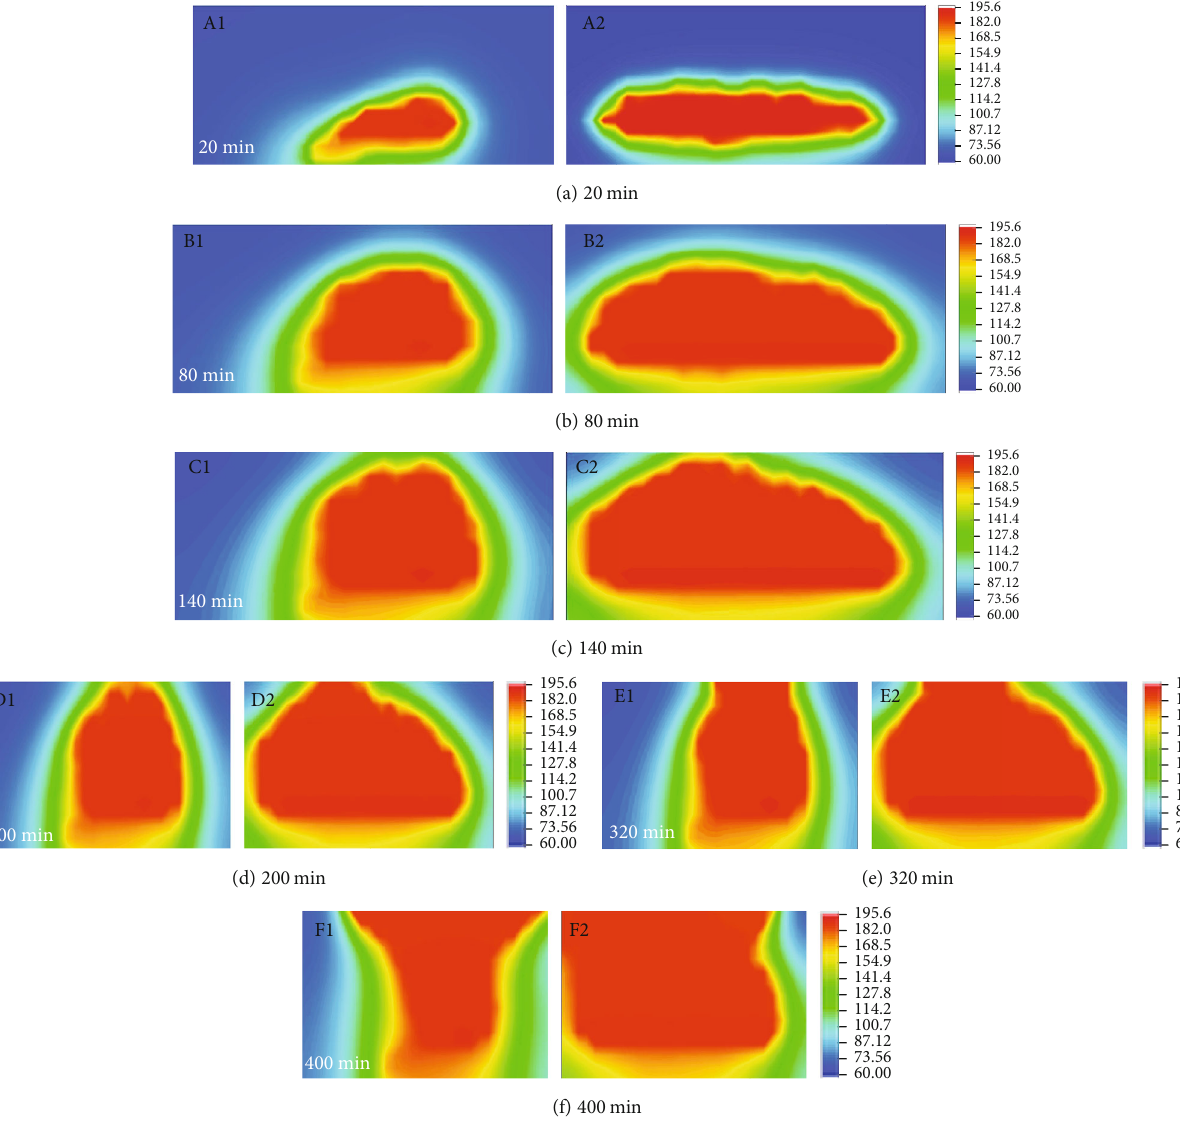
Figure 15: (a) Temperature distribution at 20 min: (A1) perpendicular to wells; (A2) along wells. (b) Temperature distribution at 80min: (B1) perpendicular to wells; (B2) along wells. (c) Temperature distribution at 140min: (C1) perpendicular to wells; (C2) along wells. (d) Temperature distribution at 200min: (D1) perpendicular to wells; (D2) along wells. (e) Temperature distribution at 320min: (E1) perpendicular to wells; (E2) along wells. (f) Temperature distribution at 400 min: (F1) perpendicular to wells; (F2) along wells. Pro fi les of temperature distribution in 3D physical dislocated well SAGD